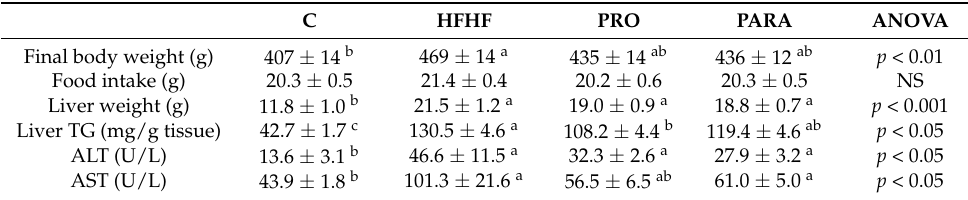
Table 2. Final body weight, food intake, liver weight, hepatic triacylglycerol (TG) content, serum alanine aminotransferase (ALT) level and aspartate aminotransferase (AST) level of rats fed a stan- dard diet (C) and a high-fat high-fructose diet alone (HFHF) or supplemented with viable or heat- inactivated Lactobacillus rhamnosus GG (PRO and PARA, respectively) for six weeks. C HFHF PRO PARA ANOVA Final body weight (g) 407 ± 14 b 469 ± 14 a 435 ± 14 ab 436 ± 12